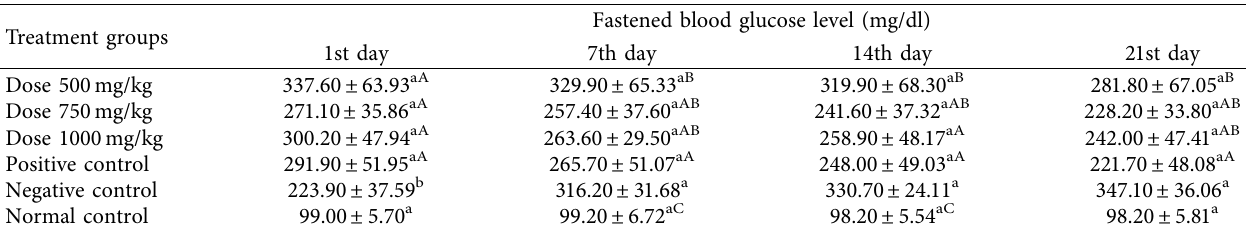
Table 2: Antihyperglycemic effects of microencapsulated bioactive product of M. stenopetala leaves extract. Treatment